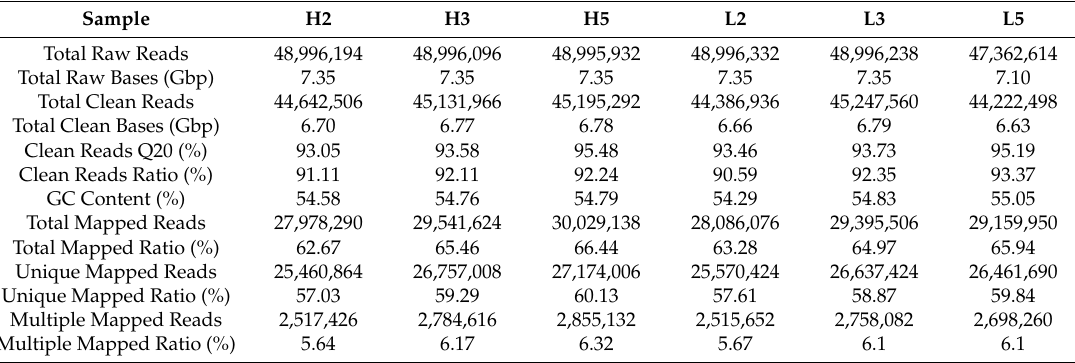
Table 2. Summary of RNA sequencing (RNA-Seq) data for each sample.